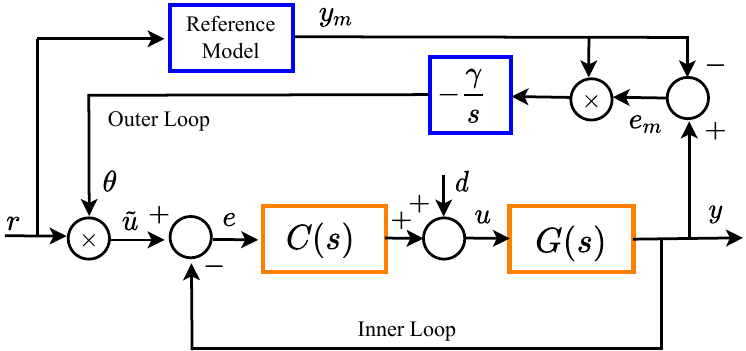
Figure 2. Block diagram of multi-loop Model Reference Adaptive Control (MRAC)-FOPID system